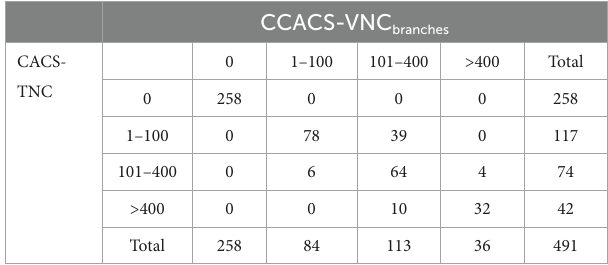
TABLE 4 Comparison of the Agatston calcium scoring risk rating between the CACS-TNC and CCACS-VNC AVG .